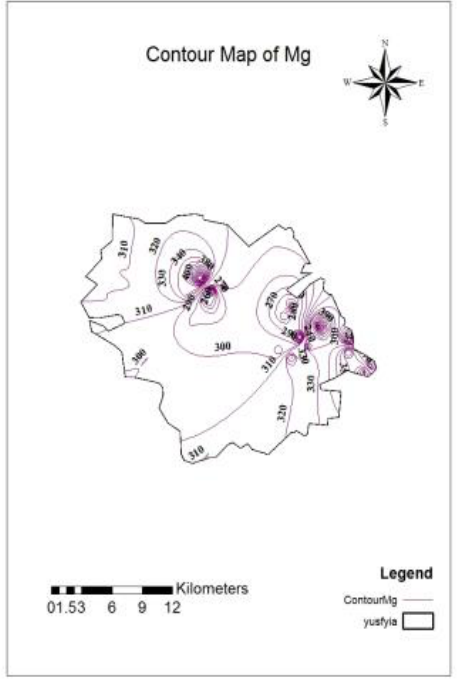
Fig.6: The interpolation and contour line of Mg map in ppm. Sodium ion (Na + )